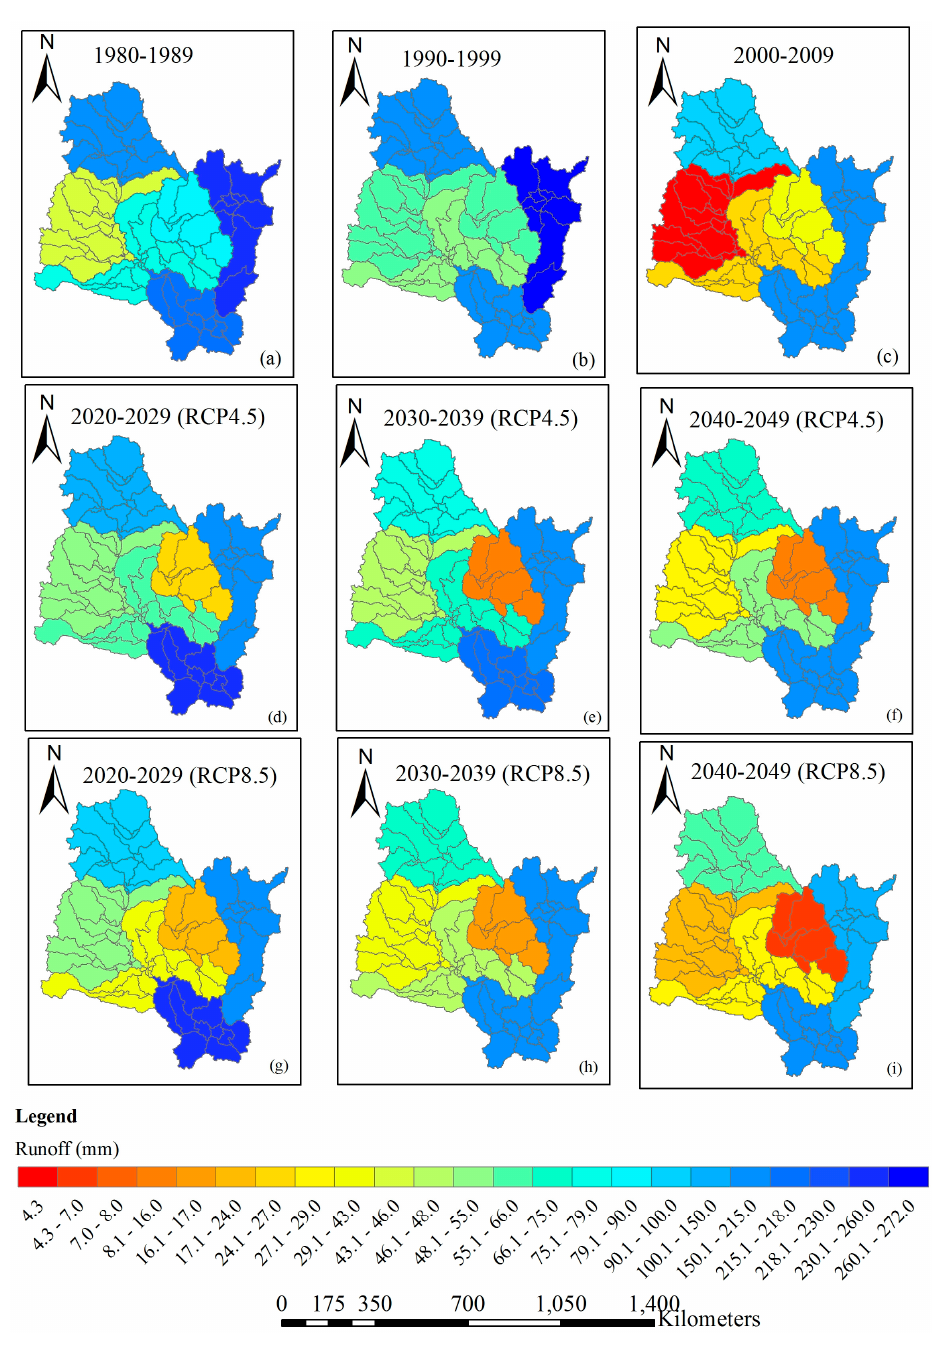
Figure 8. Spatial characteristics of annual runoff in the Songhua River Basin for different decades under baseline condition ( a – c ) and future climate scenarios (RCP 4.5 ( d – f ) and RCP 8.5 ( g – i )). Spatial variations of runoff within the six units are not considered.